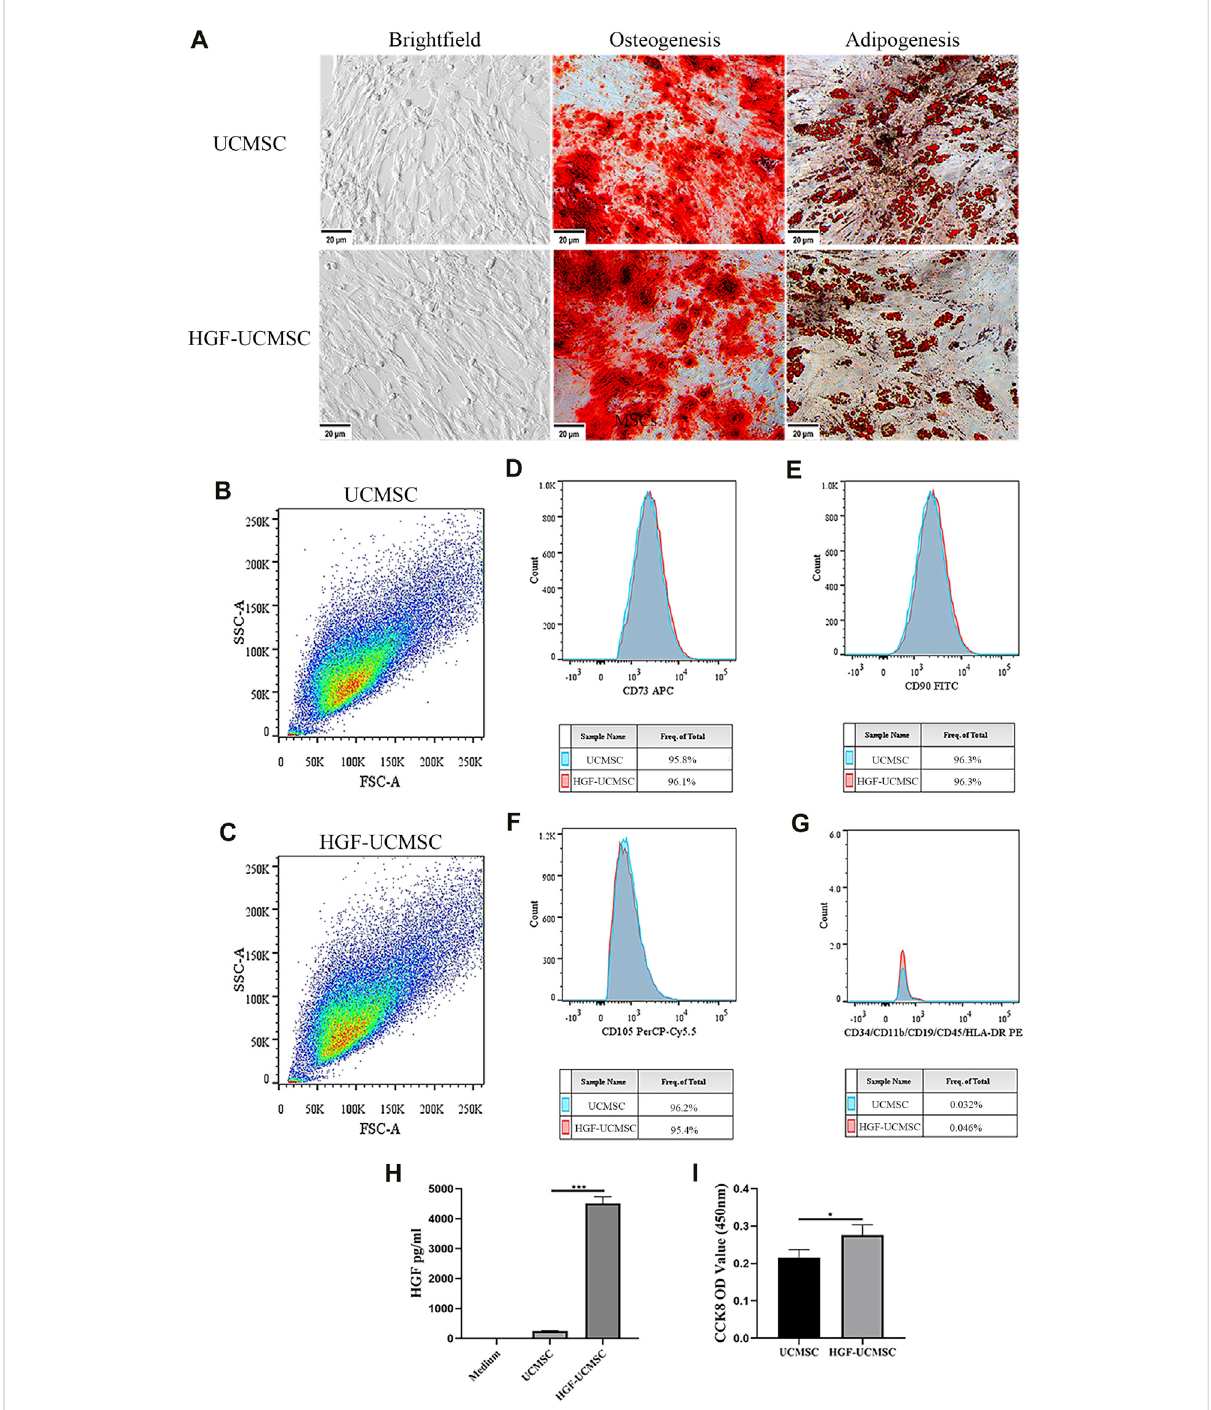
FIGURE 2 Characteristics of UCMSCs and HGF-UCMSCs. (A) Regularly cultured MSCs were induced into osteoblasts and adipoblasts stained with alizarin red and Oil Red O, respectively (magni fi cation:×100). (B – G) Flow cytometry wasutilizedto analyze the physical features and cell surface markers of MSCs (H) TheconcentrationofHGFintheconditionedmediumwasdetectedusingacommercialELISAkit (I) TheproliferationofMSCswasassessed by CCK8 assay. Values are presented as mean ± standard deviation. * p < 0.05; ** p < 0.01; *** p <